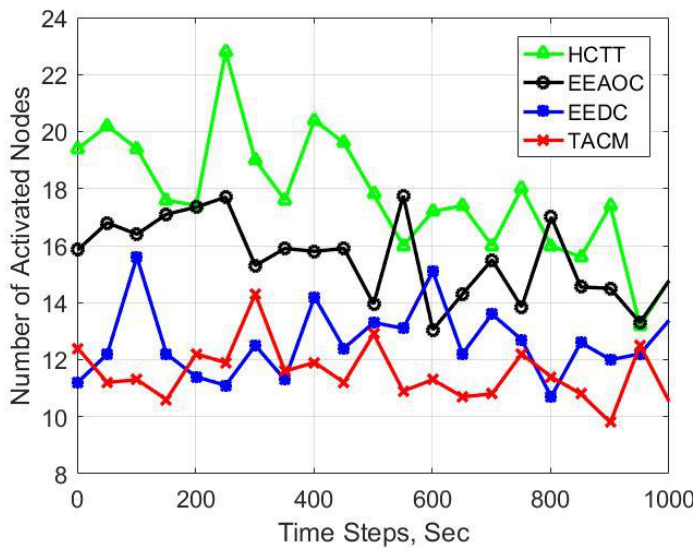
Figure 11. Experimental result for number of activated nodes in the network.